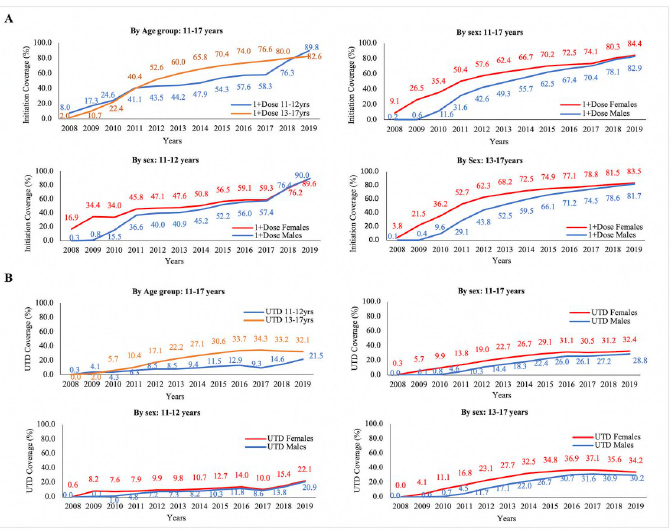
Fig 1. HPV vaccine coverage rates stratified by age group and sex from 2008 to 2019. (A) HPV Vaccine Initiation Coverage Rates, (B) HPV Vaccine UTD Coverage Rates.